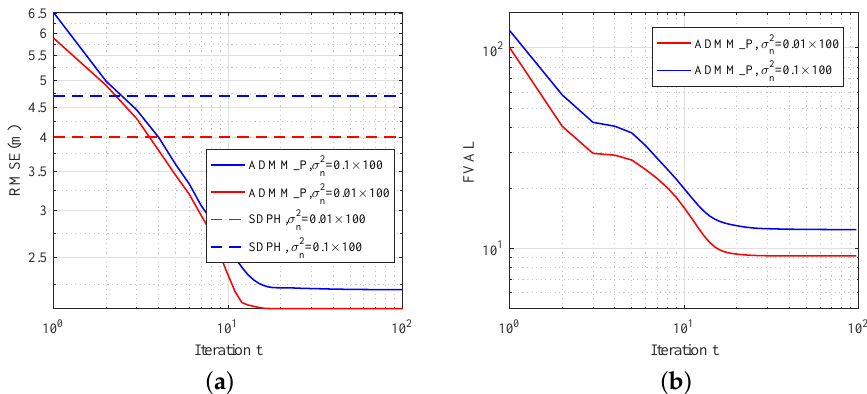
Figure 5. Estimation results with different σ 2 n for N = 40, M = 10 sensor network versus iteration number t . Probability of NLOS connections was set to P NLOS = 95%. ( a ) RMSE; ( b ) convergence properties.